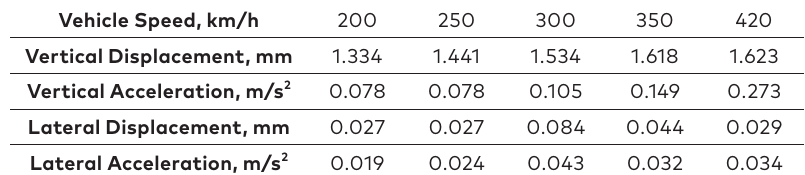
Table 7. Peak dynamic response at bridge